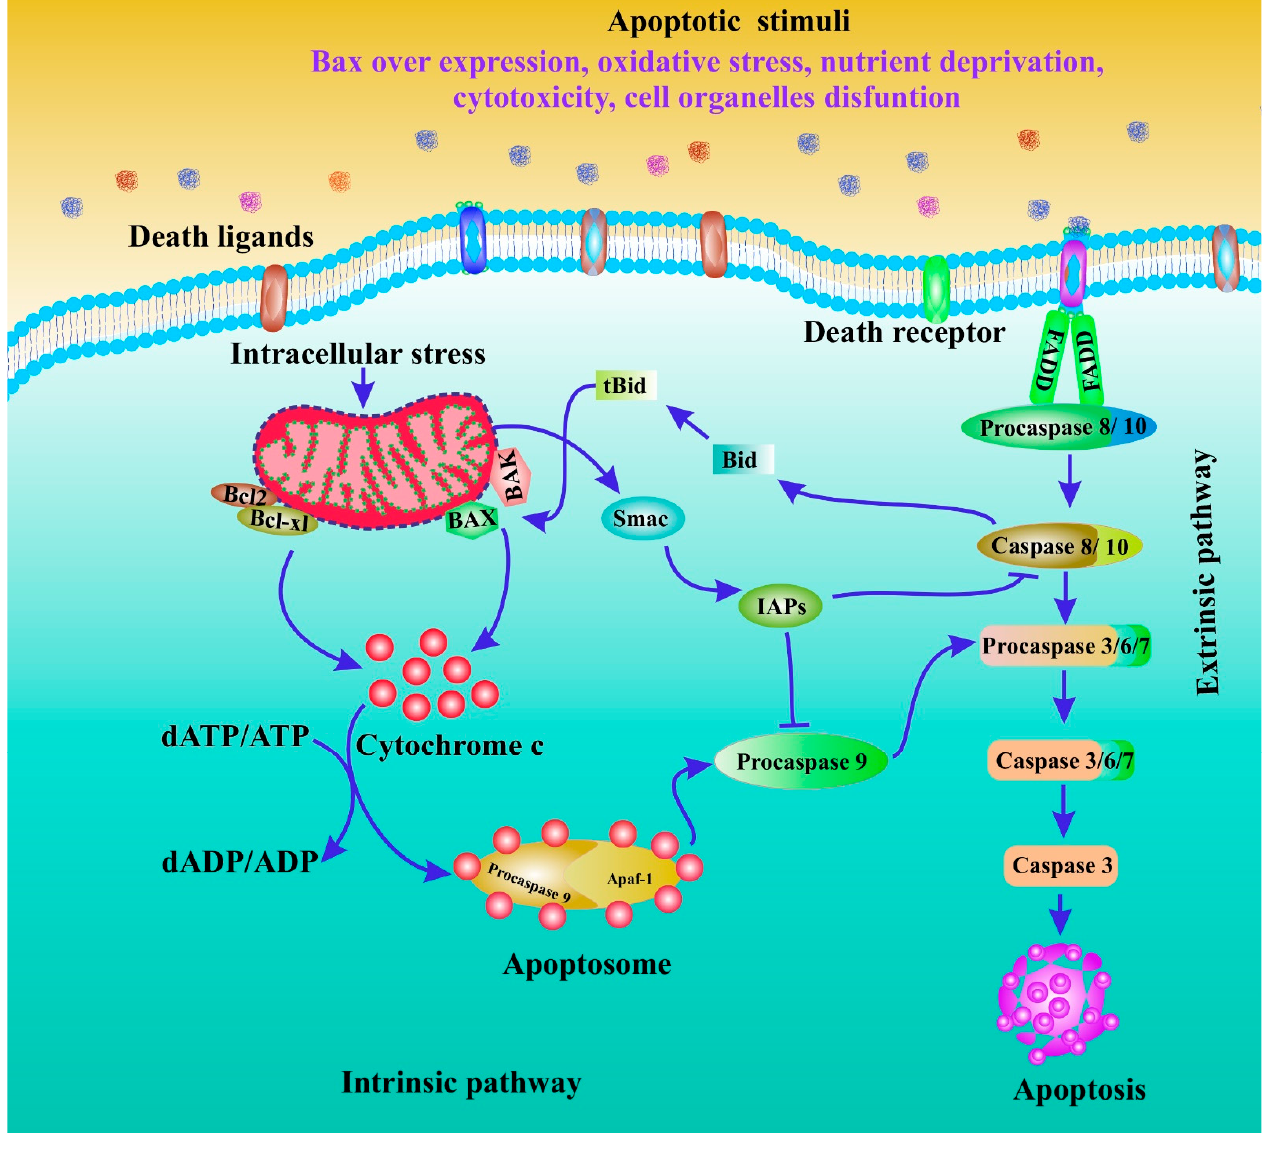
Figure 1. Role of apoptosis in cancer treatment.